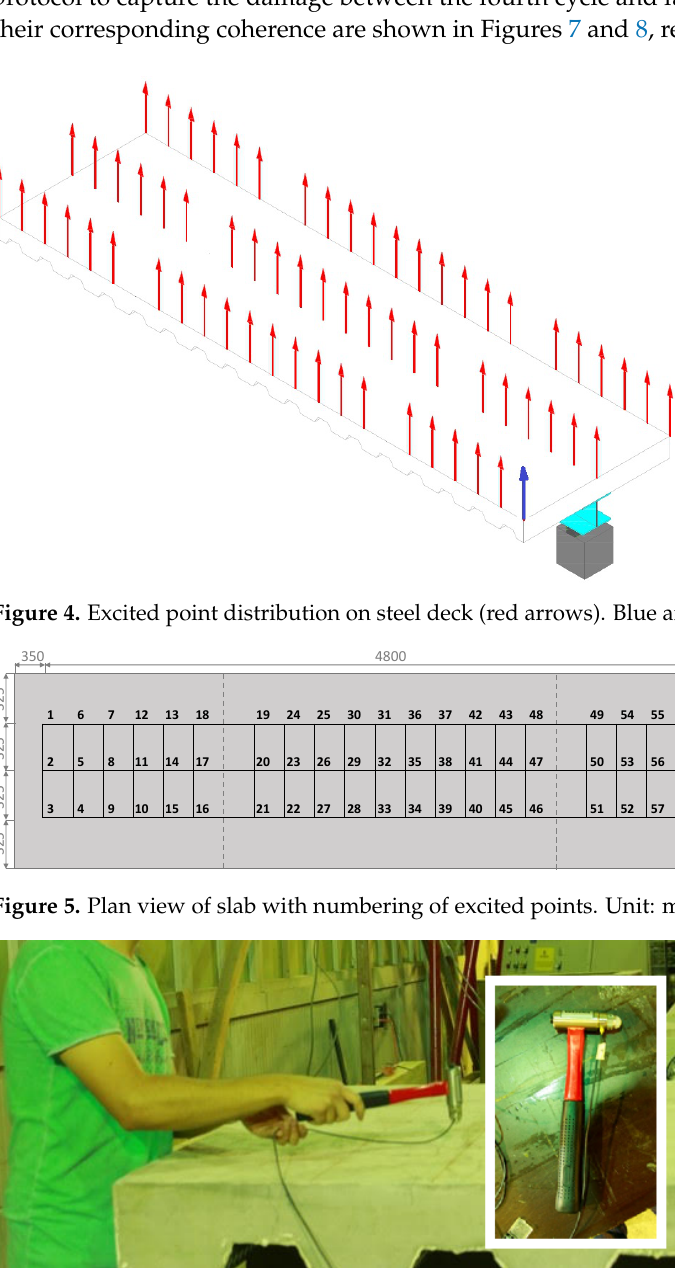
Figure 6. Photograph of the actual experiment in which the hammer modal testing procedure is applied to the concrete-steel beam. The inset figure shows the hammer used to measure vibration